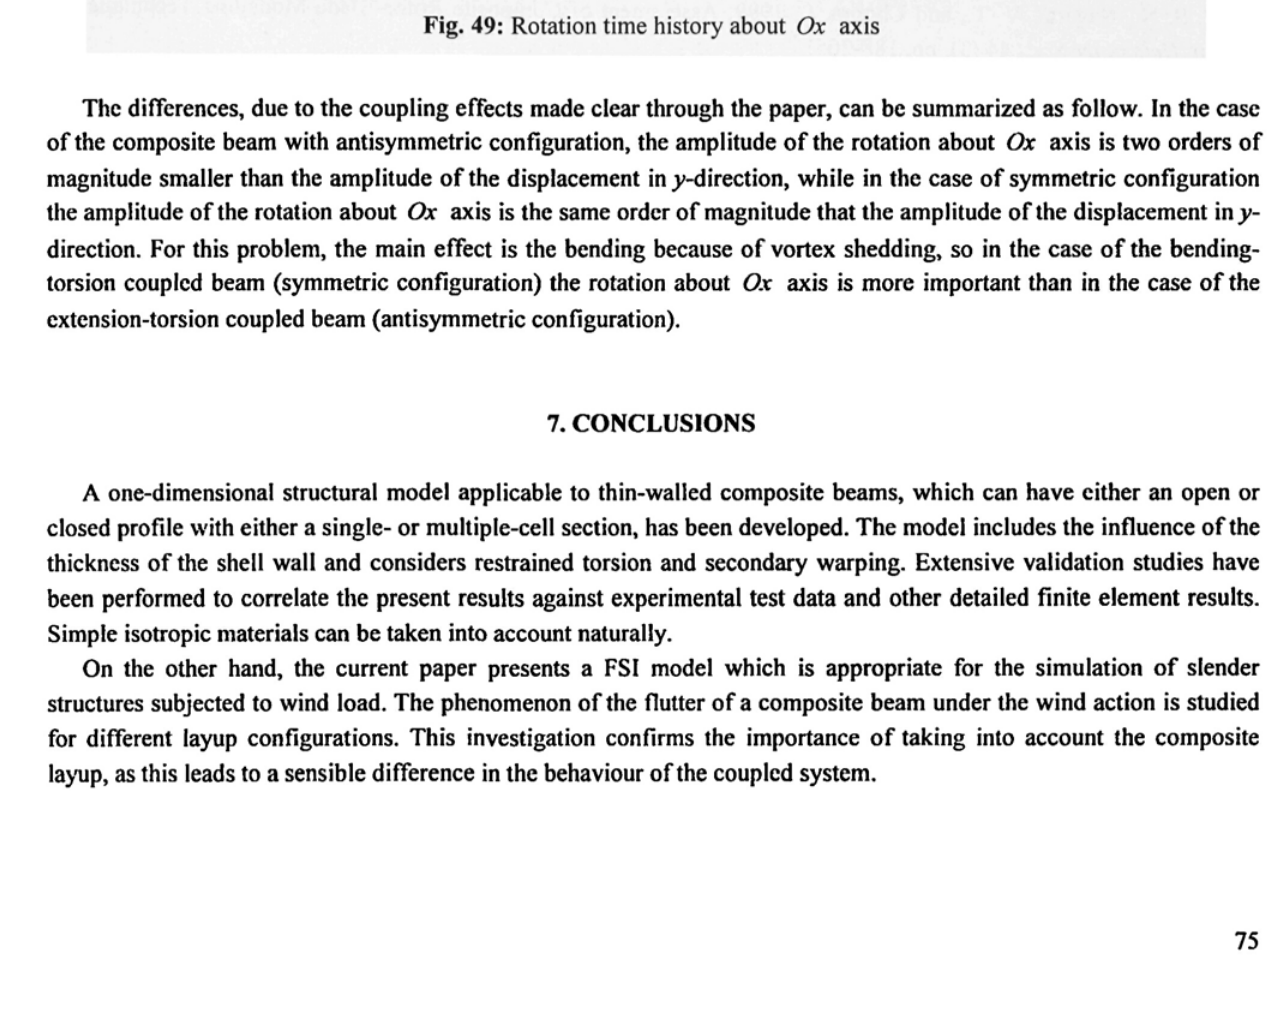
Fig. 49: Rotation time history about Ox